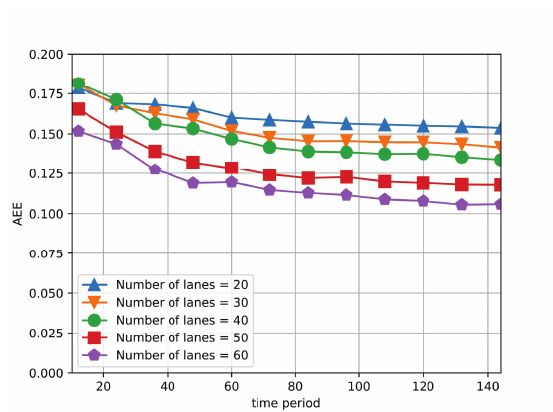
Figure 4. The AEE of four sets of road segments under different time